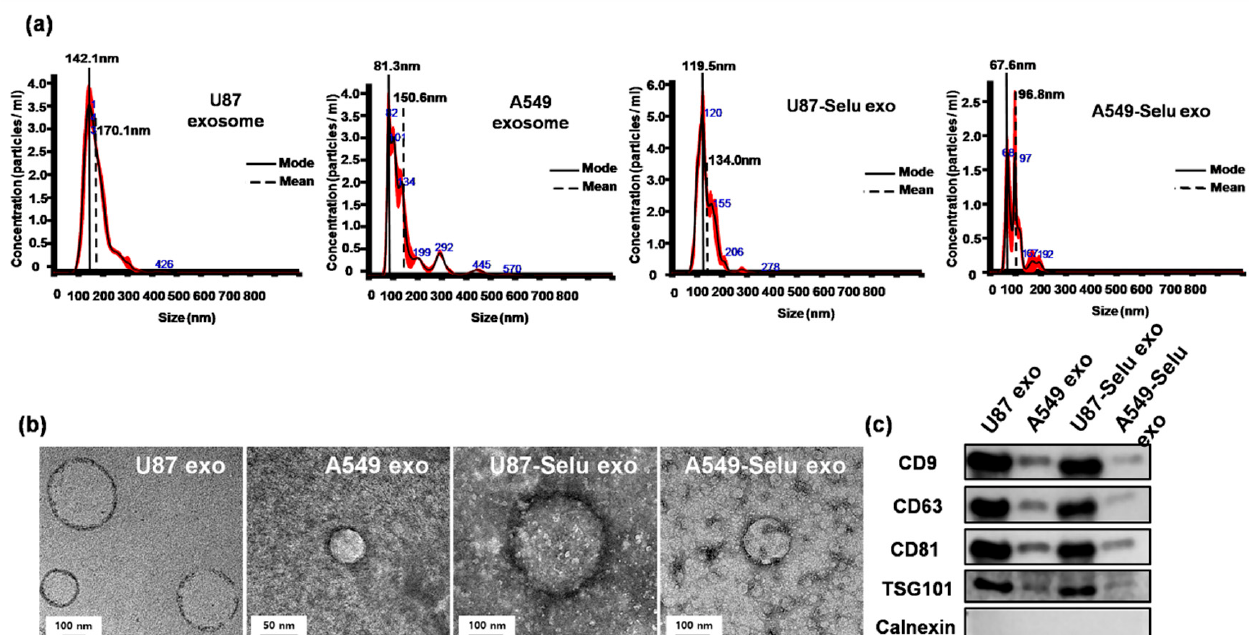
Figure 5. Characterization of U87 exo, A549 exo, U87-Selu exo, and A549-Selu exo. ( a ) NTA results showed the mean and mode size of the exosomes (black: mean value, red: error). The loading of selumetinib changed the size distribution of the exosomes for both U87 and A549 derived exosomes. n = 3. ( b ) TEM images showed that all exosomes were round in shape. ( c ) Immunoblotting results revealed that U87-derived exosome-specific exosomal markers (CD proteins and TSG 101) were highly expressed in U87-derived exosomes, but not in A549-derived exosomes. A non-exosomal marker (Calnexin) was used as reference, n = 3.